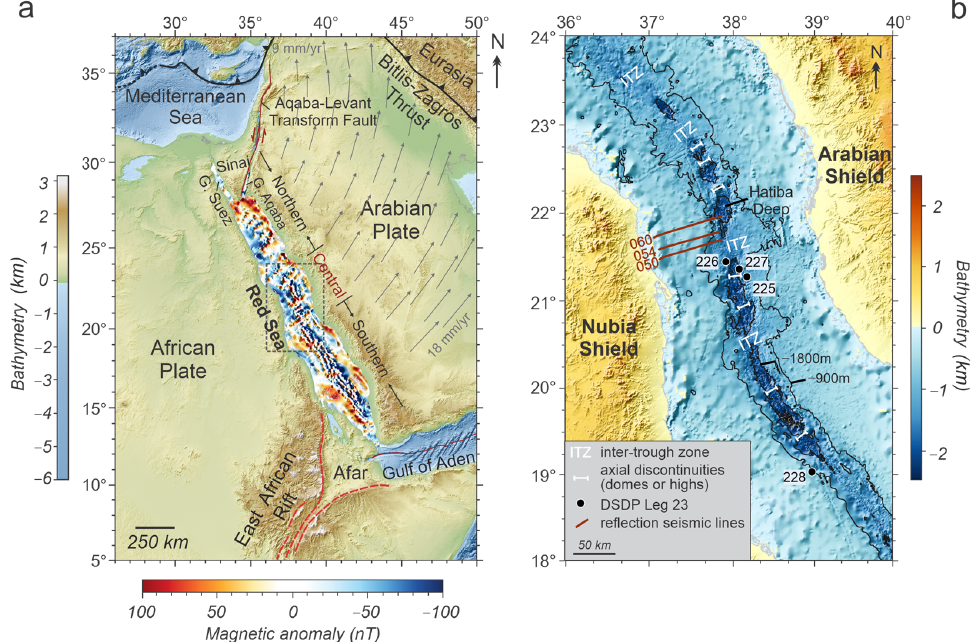
Figure 1. ( a ) Tectonic settings and the magnetic anomaly map of the Red Sea Rift. Bathymetry data are from the GEBCO Compilation Group 2021 (https://www.gebco.net, accessed on 3 September 2021); magnetic anomaly data are from EMAG2 (https://ngdc.noaa.gov/geomag/emag2.html, accessed on 2 March 2020). Grey arrows show the plate movement of the Arabian Plate relative to the Nubia Plate, and the direction and velocity are calculated from the model MORVEL [40]. Grey dashed box shows the area of Figure 1b. ( b ) Bathymetry of the Central Red Sea. Red lines show the locations of the re fl ection seismic pro fi les used in this study, the black dots show sites 225–228 on the DSDP Leg 23 [24,41–43], and the white lines represent the “discontinuities” between axial deeps within the trough.